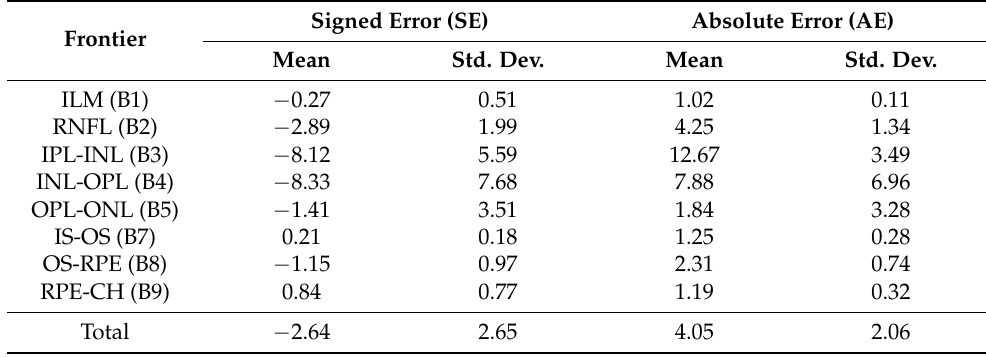
Table 3. Segmentation performance in the case of retinas with